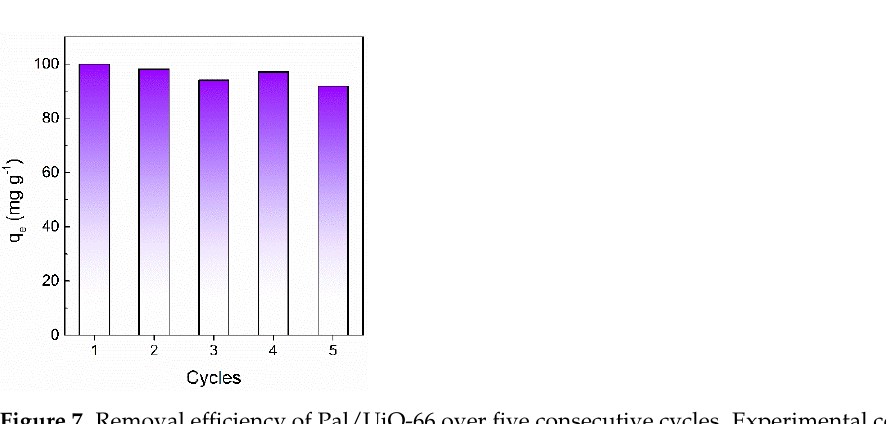
Figure 7. Removal efficiency of Pal/UiO-66 over five consecutive cycles. Experimental conditions: 60 mg L − 1 initial MO concentration, 0.4 g L − 1 of the adsorbent, pH = 5, volume 50 mL, and T = 25 °C.